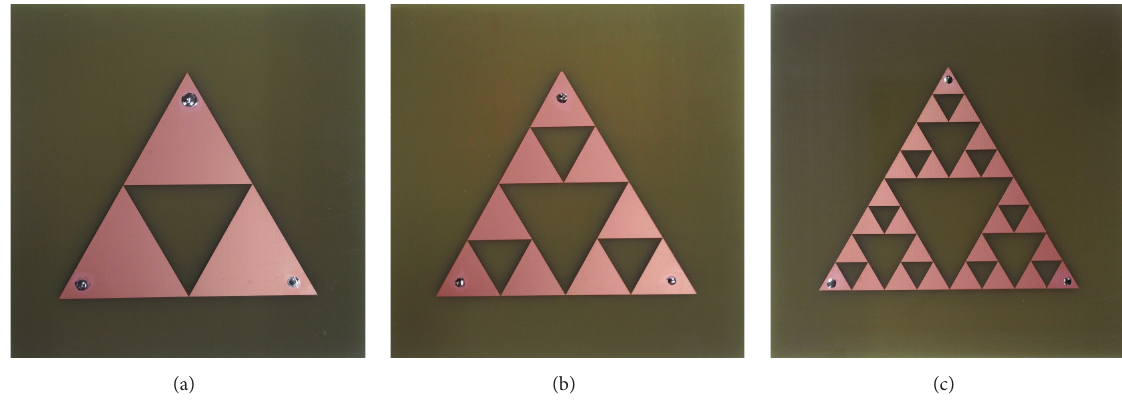
Figure 4: The fabricated antennas at three orders: (a) 1st order, (b) 2nd order, and (c) 3rd order.